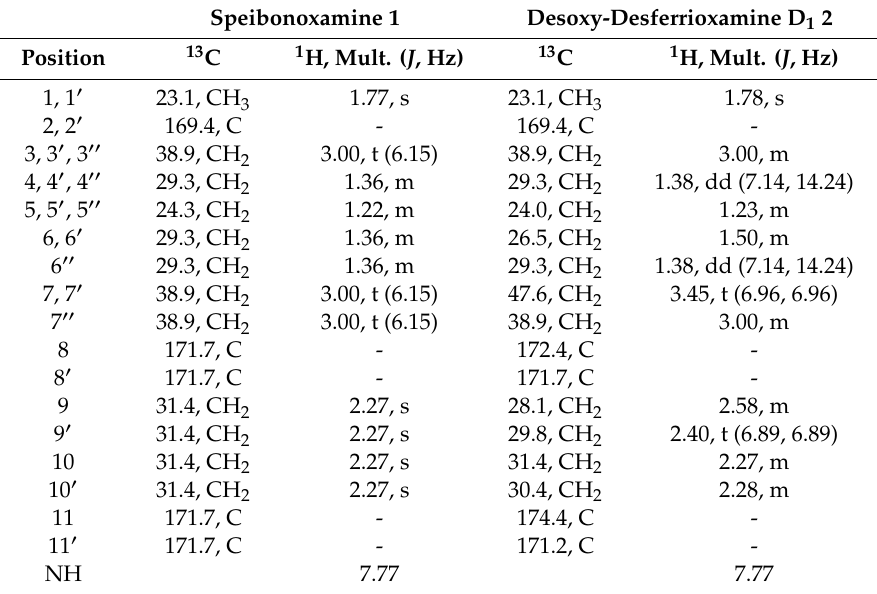
Table 2. 1 H and 13 C-NMR data of speibonoxamine 1 and desoxy-desferrioxamine D 1 2 in DMSO- d